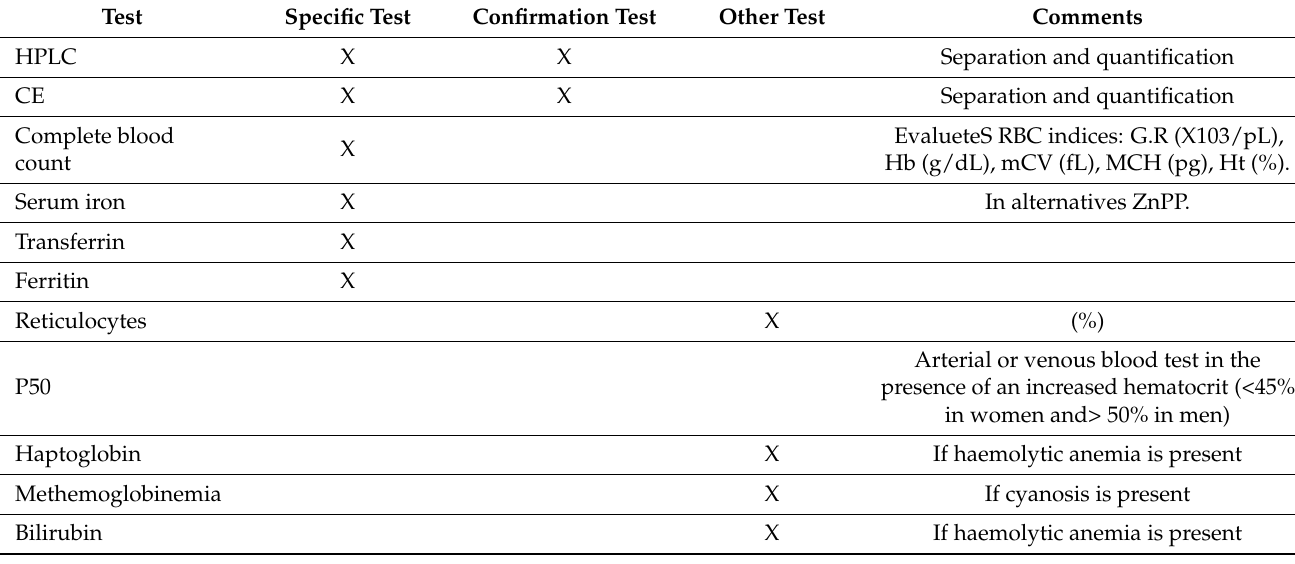
Table 3. Common variants